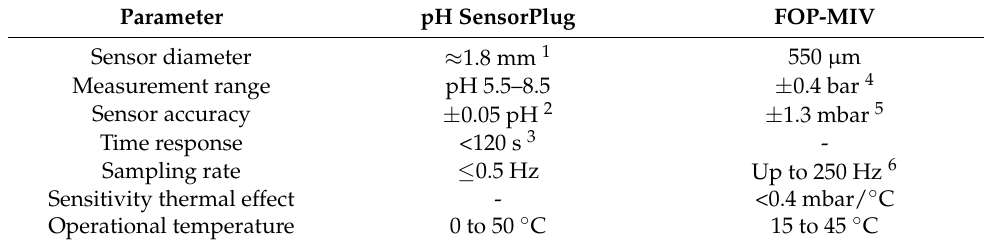
Table 1. Specification of pH SensorPlugs and FOP-MIV sensors. Data extracted from [31,32].